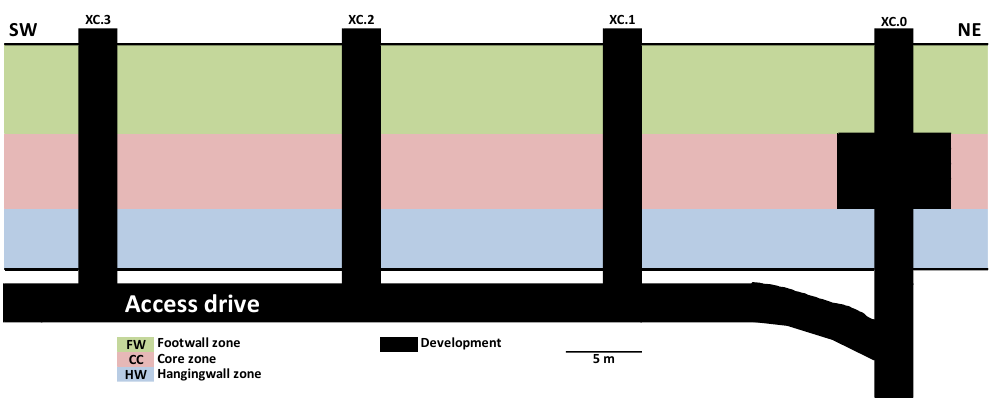
Figure 2. Plan of underground exploratory development within the SVZ.